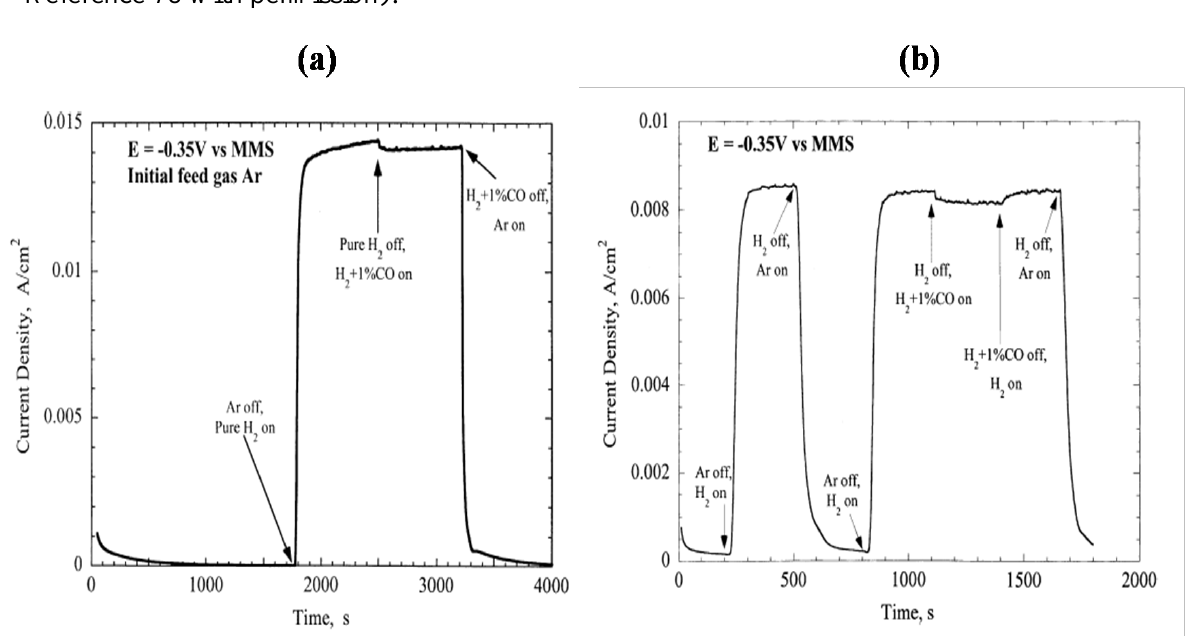
Figure 4. CO tolerance test of (a) pure WC, (b) Co containing WC (Reprinted from Reference 78 with